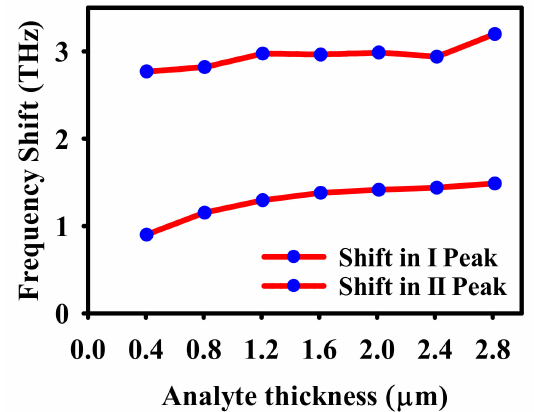
Figure 9. Dependency of frequency shift on analyte